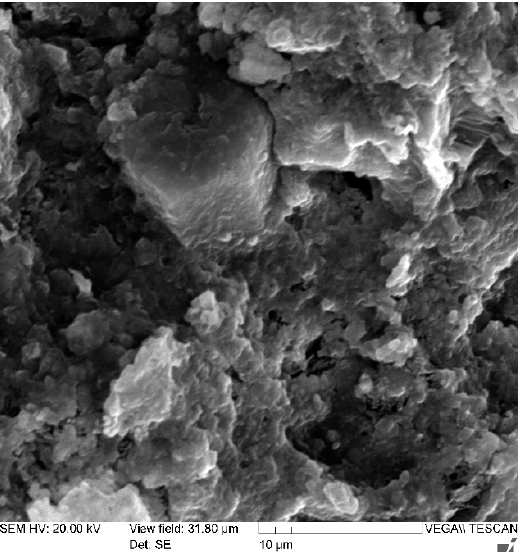
Figure 9. Photo of the microstructure of a cement stone with an MS-85 additive in an amount of 6%: ( a ) with 2000× magnification ( b ) with 1000× magnification.